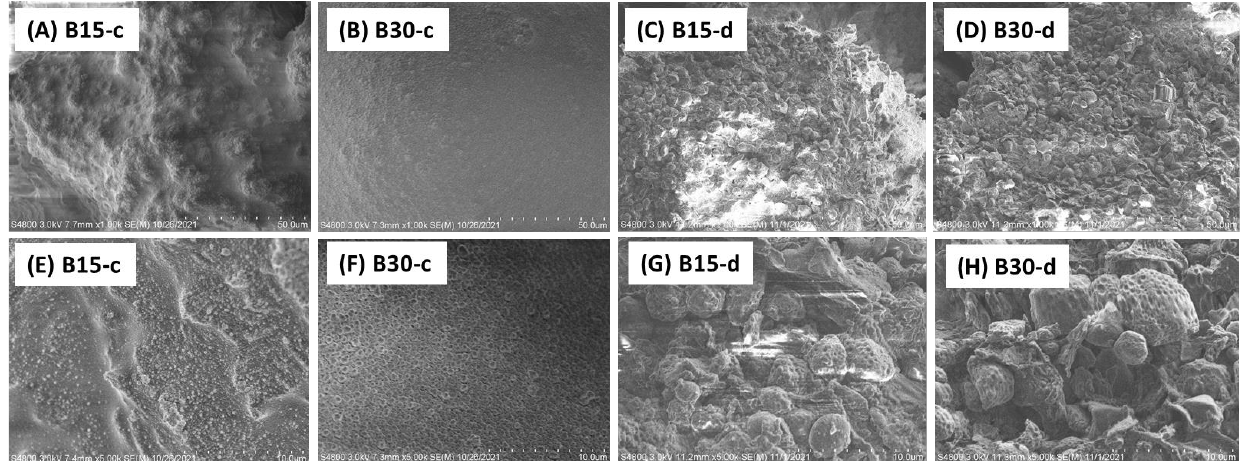
Figure 2. SEM images of cottonseed butter products with 15 (B15) and 30 min (B30) kernel roasting at 150 ◦ C. Suffixes “c” and “d” indicate “cryo-SEM” and “de-oiled” samples, respectively. Bar distance is 50 and 10 µm, respectively, for upper and lower rows.